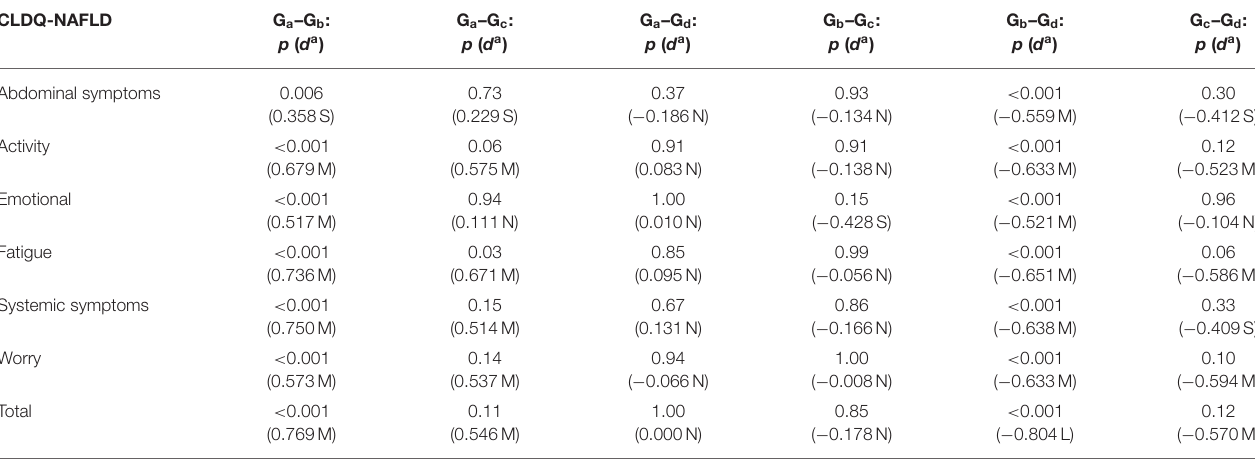
TABLE 7 | Comparison of quality of life (CLDQ-NAFLD) between non-alcoholic fatty liver disease (NAFLD) severity groups: non-alcoholic steatohepatitis (NASH; with and without significant fibrosis) and no-NASH (with and without significant fibrosis).